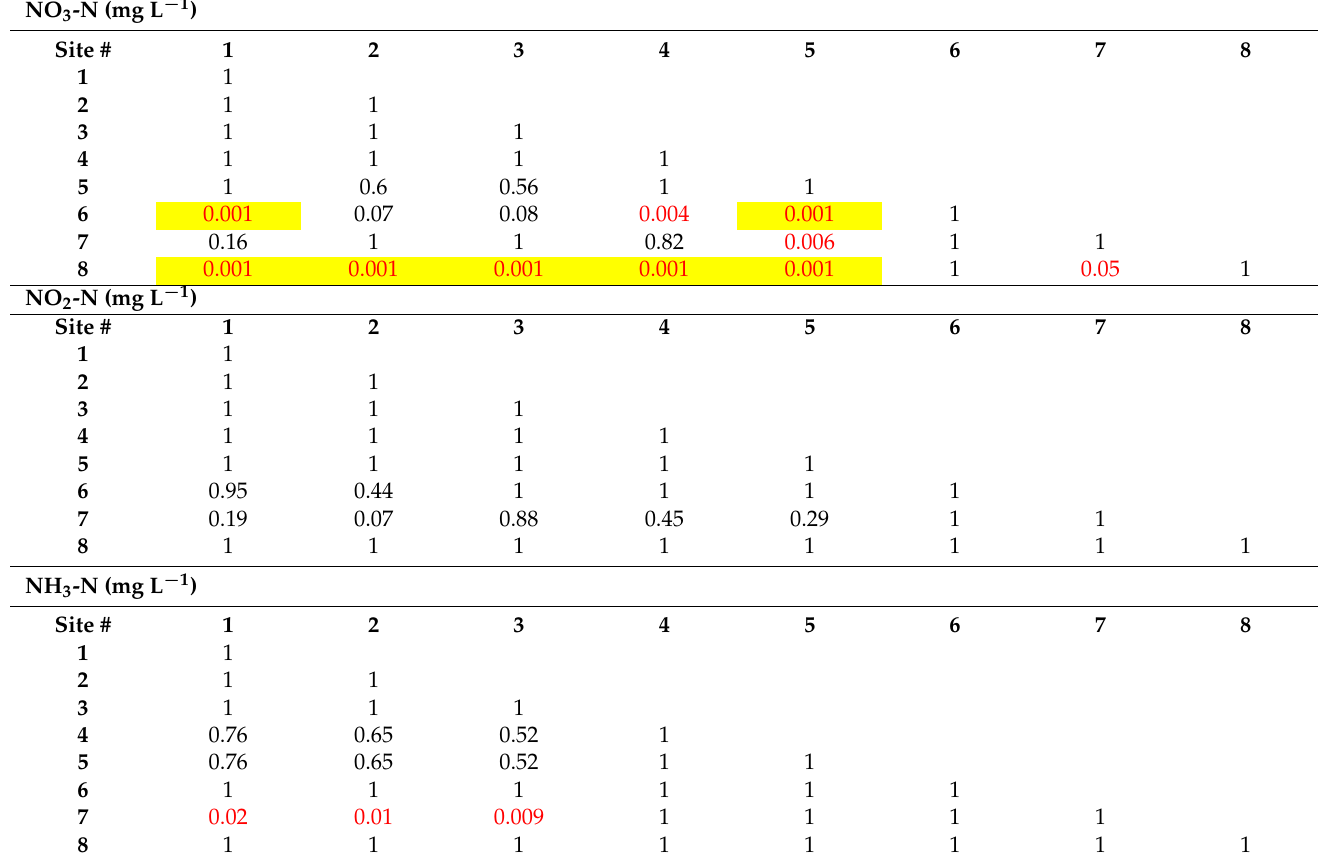
Table A1. Results of inter-site comparisons, via Friedman’s ANOVA and Dunn’s post hoc multiple comparison tests, for significant differences ( CI = 95%) between surface water nutrient